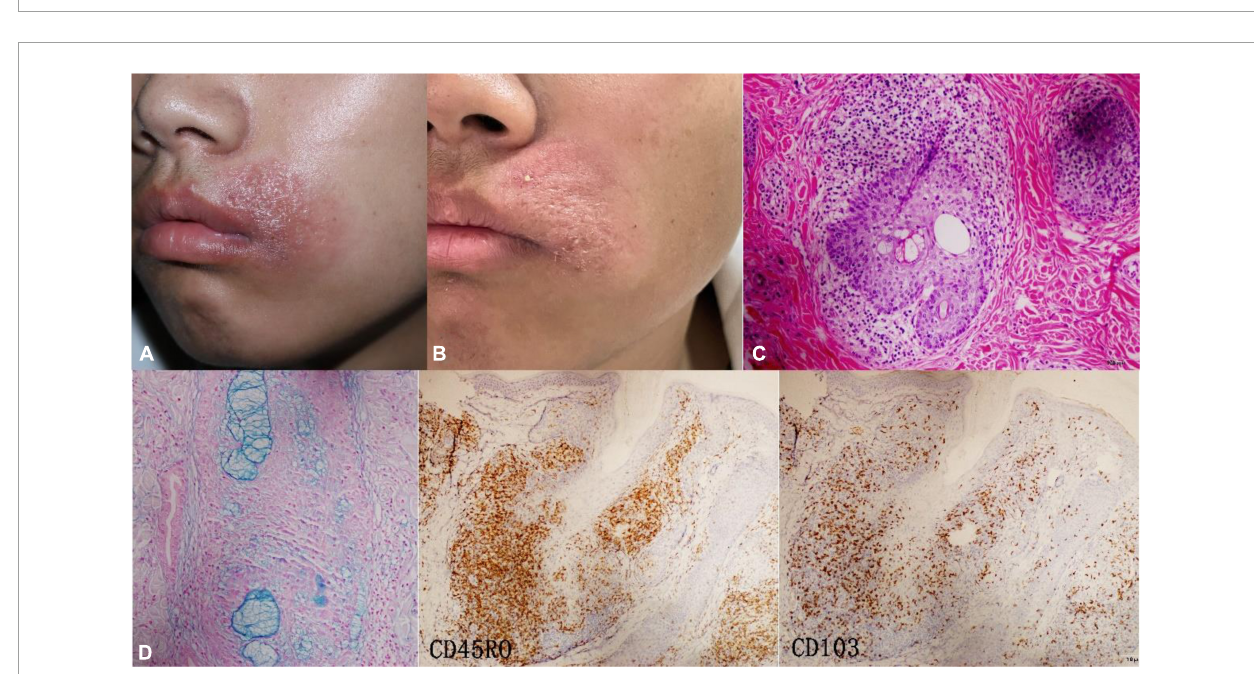
FIGURE2 Case4 (localized MF-FM). (A) At first visit, the boy presented with perioral red plaque on the left side. (B) After three times ALA-PDT, the sense of infiltration significantly decreased. (C) Alcian blue staining was positive. (D) Histopathology showed a dense infiltration of lymphocytes around the follicle. IHC, CD45RO (+++) CD103